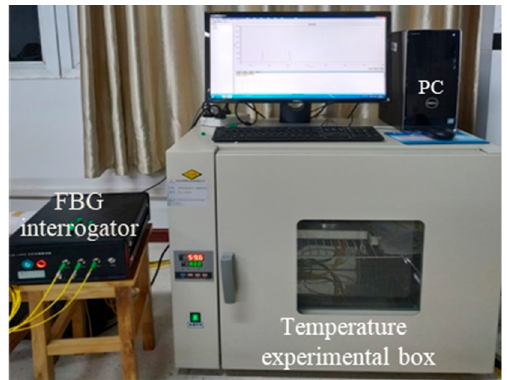
Figure 7. Temperature test device.